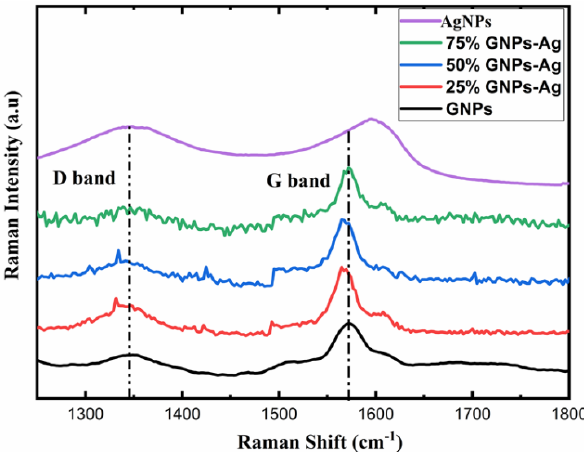
Figure 3. Raman analysis with active vibrational modes of AgNPs, GNPs and (Ag) 1-x (GNPs) x .